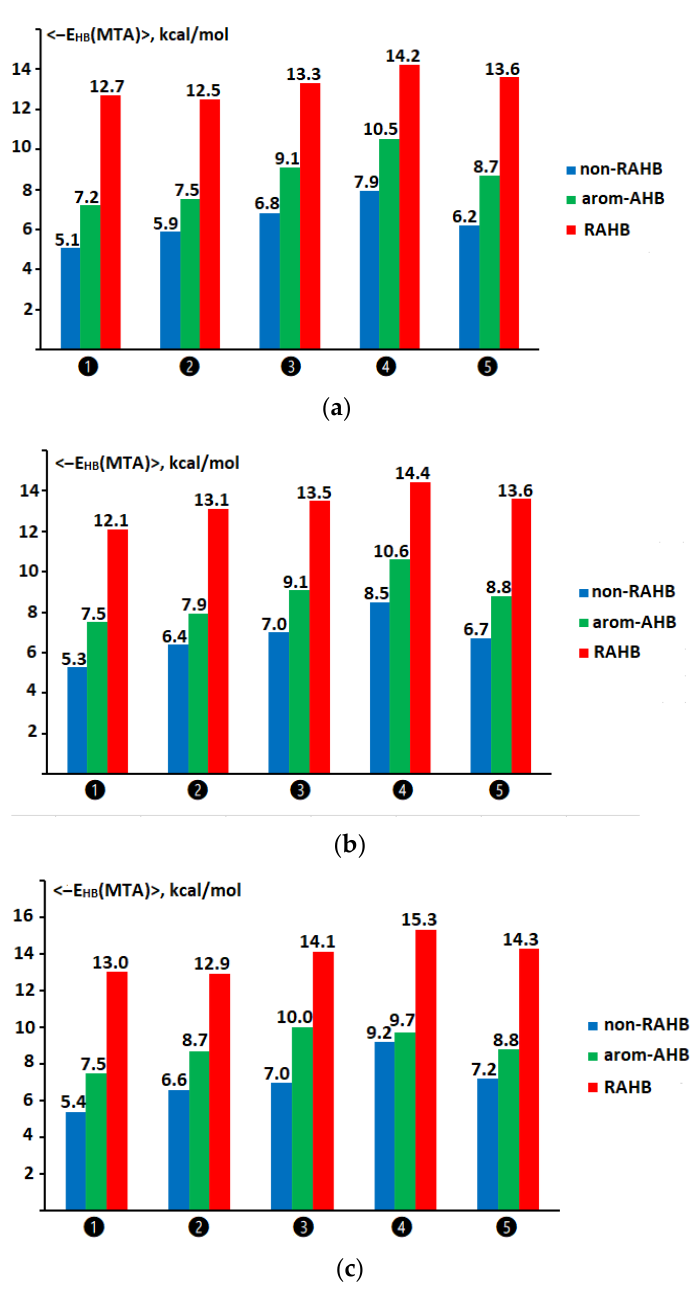
Figure 3. The average < ‒ E HB (MTA)> IMHB energy for compounds of the non ‐ RAHB (blue), arom ‐ AHB (green), and RAHB (red) clusters estimated via MTA method: range ρ BCP and V BCP — ❶ 0.030–0.035 a.u., ❷ 0.035–0.040 a.u., ❸ 0.040–0.046 a.u., ❹ 0.046–0.051 a.u., ❺ 0.030–0.051 a.u. (total range), ( a ) and ( b ), respectively; range r O···H — ❶ 1.75–1.80 Å, ❷ 1.70–1.75 Å, ❸ 1.65–1.70 Å., ❹